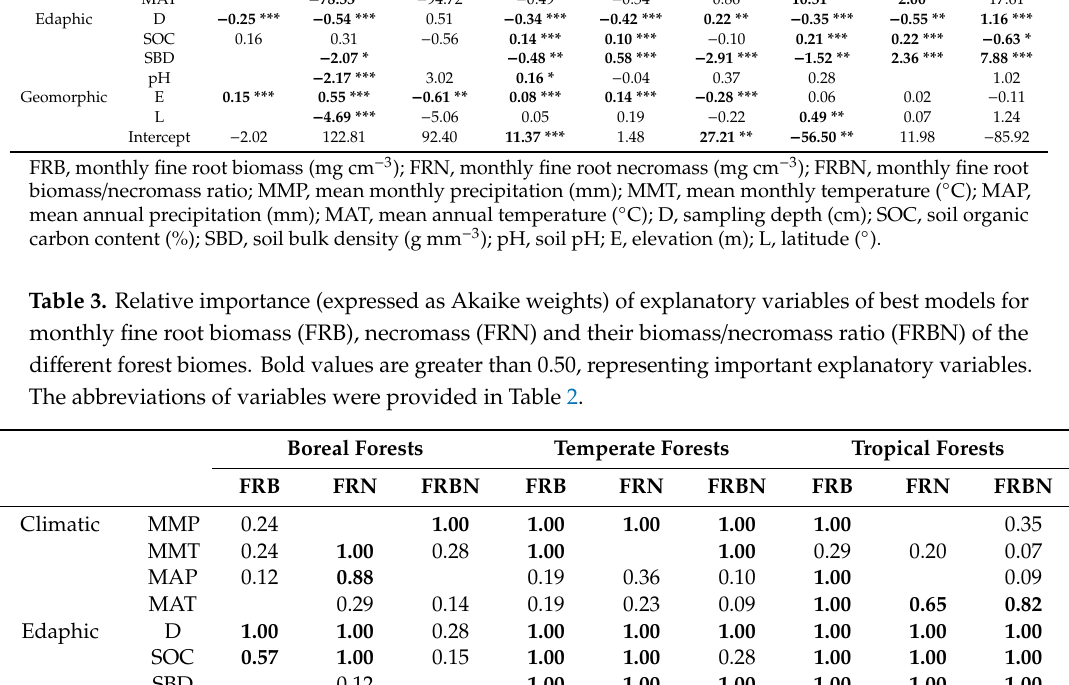
Table 2. Linear mixed effects model coefficient estimated from the average best-fitting models (conditional average), predicting the monthly fine root biomass, necromass and their biomass / necromass ratio for boreal forests ( n = 52), temperate ( n = 886) and tropical ( n = 130). Non-significant results were shown if they were retained in the model. Significant results were shown in bold and marked with asterisks (* p < 0.05; ** p < 0.01; *** p < 0.001). The values of monthly fine root biomass, necromass and the biomass / necromass ratio were log(x + 1) transformed. The temperature transformation log(x + 273) was used. Boreal Forests Temperate Forests Tropical Forests FRB FRN FRBN FRB FRN FRBN Climatic